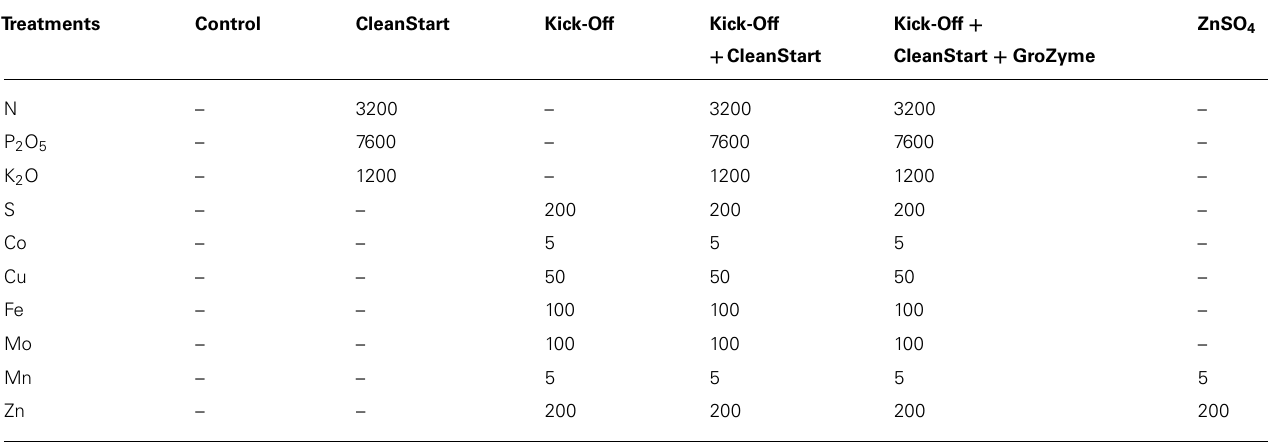
Table 1 | Elemental composition of the foliar fertilizers (mg L –1 in solution).